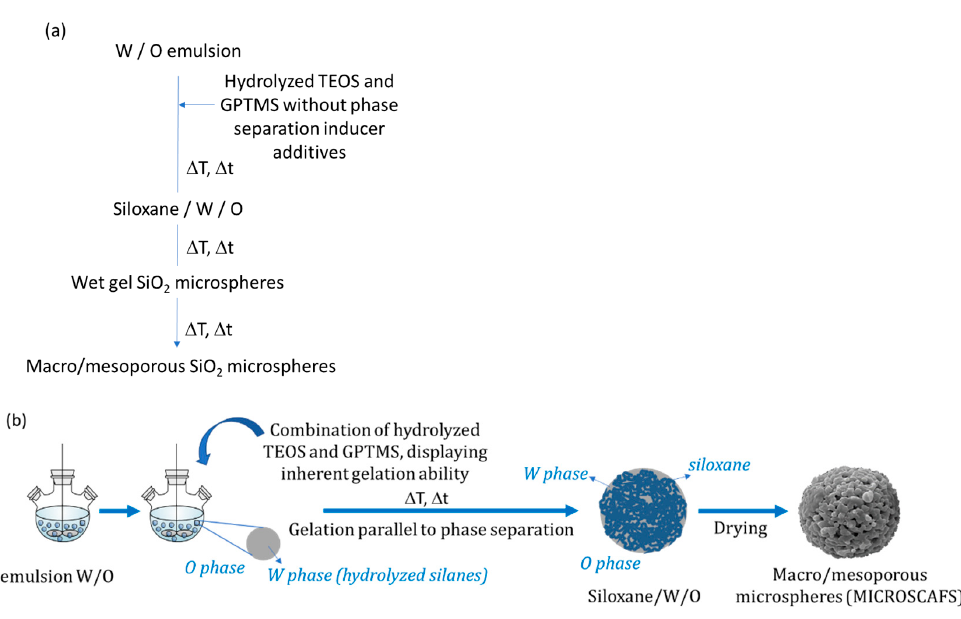
Figure 25. ( a ) Preparation schemes for the sol-gel derived macro/mesoporous SiO 2 microspheres (MICROSCAFS), synthesized from TEOS and GPTMS, obtained by W/O emulsion combined with sol-gel transition and phase separation, in the absence of any gelation or phase separation inducer additive: ( a ) representative synthesis flowchart; ( b ) drawing scheme. The O phase is composed by decahydronaphthalene (decalin) and Span 80. (Marques et al., original schemes).